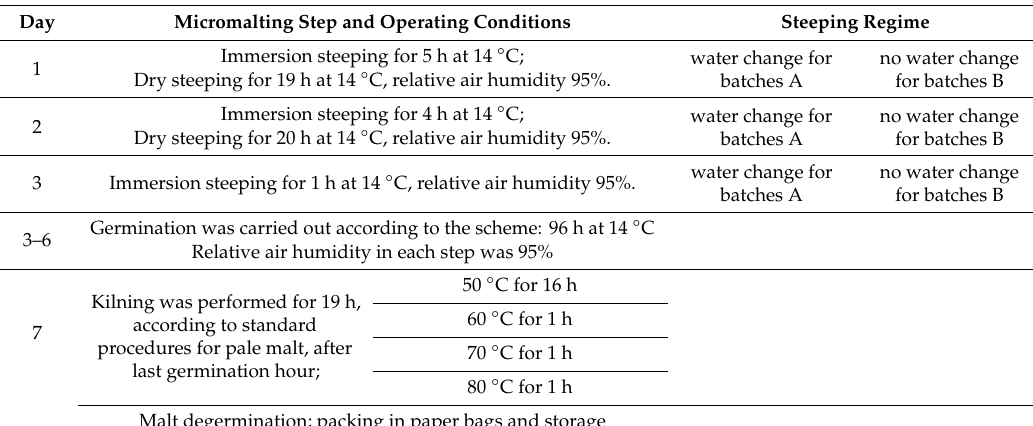
Table 1. General micromalting scheme of barley samples